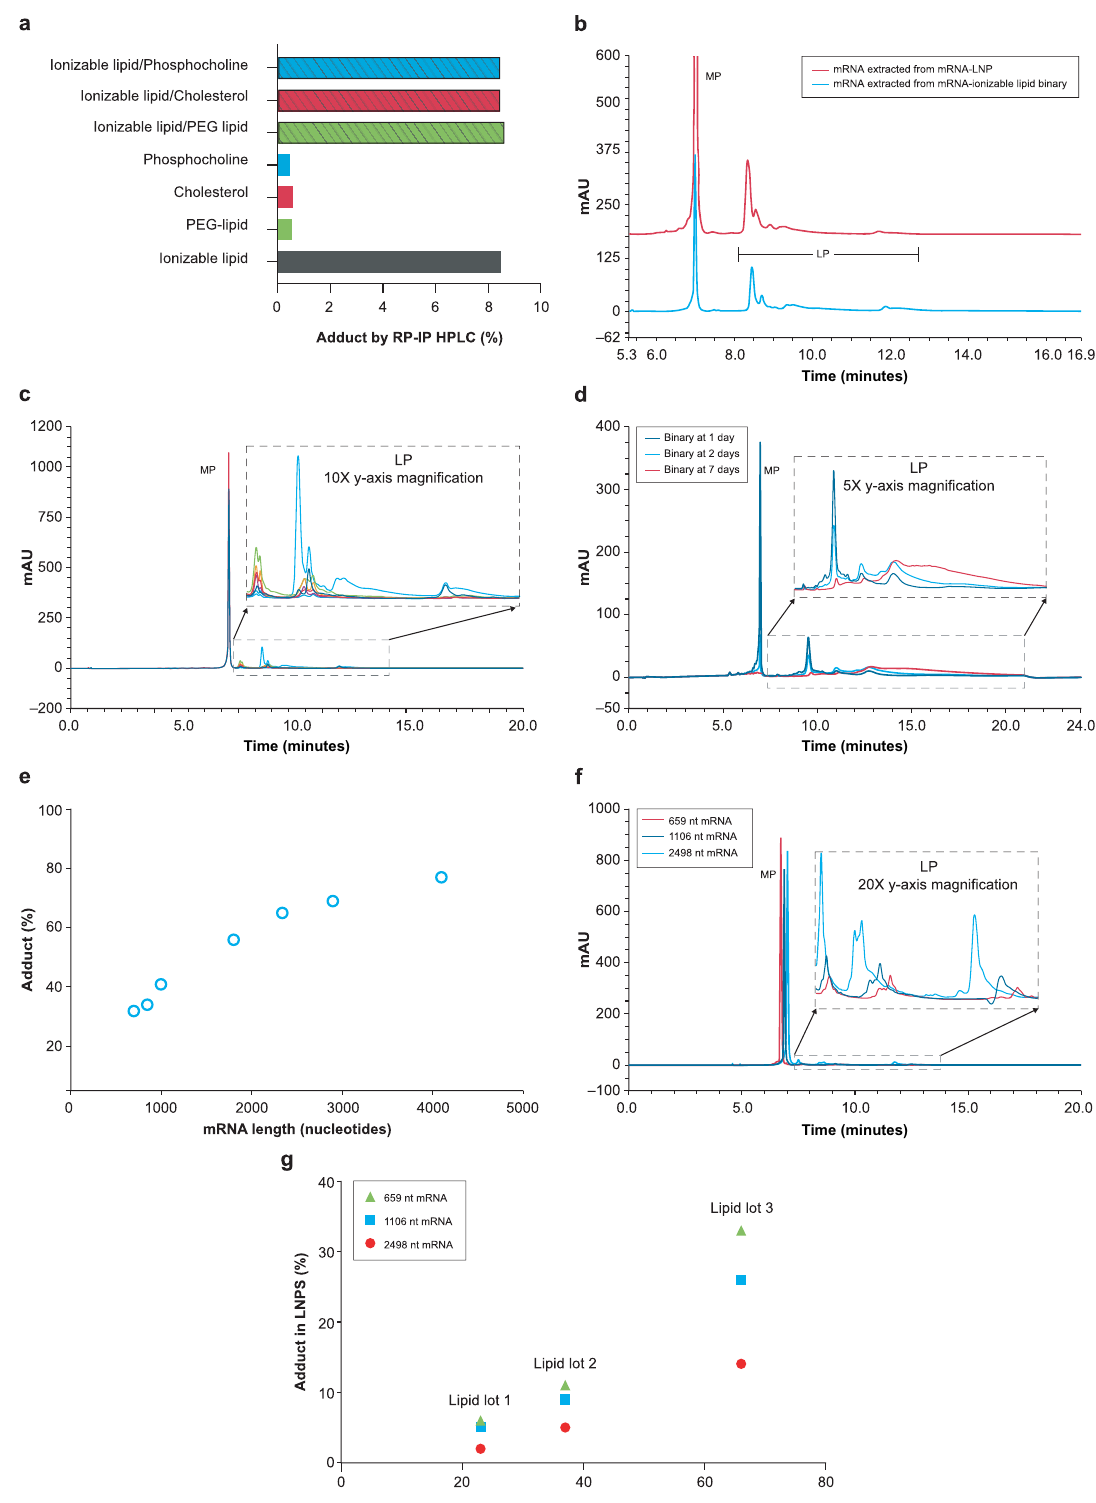
extracted mRNA, and hEPO assay control (Fig. 6a); in contrast, very low protein expression was detected from the isolated LP (Fig. 6a). Separately, 5 LNP formulations were subjected to var- ious levels of degradation, after which the mRNA was extracted from the LNP and analyzed by RP-IP HPLC, CE, and for in vitro protein expression in HeLa cells (Fig. 6b). When mRNA integrity